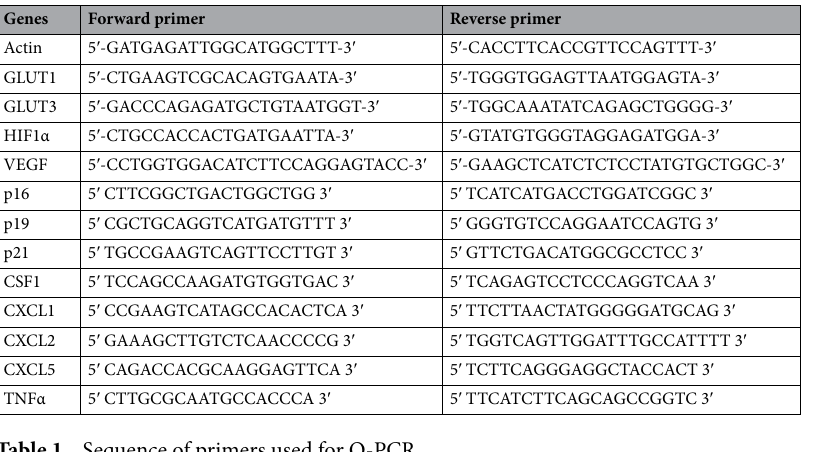
mRNA expression levels were calculated using the comparative Ct method (2 −ΔΔCt ) and normalized to the house- keeping gene. All RT-qPCR assays were performed in triplicate and results were represented by the mean values. Preparation and analysis of protein extracts.